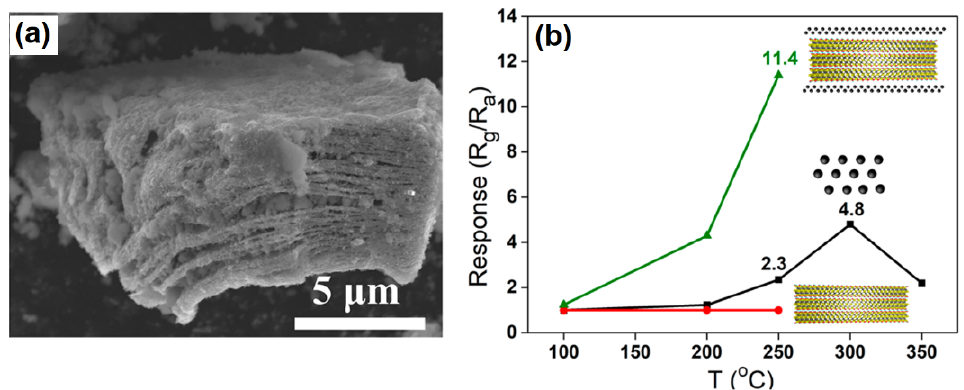
Figure 14. ( a ) TEM image of T 3 C 2 T x /CuO composite. ( b ) Gas sensor response of CuO, T 3 C 2 T x and T 3 C 2 T x /CuO composite to 50 ppm of toluene. Adapted with permission from [48]. Copyright © 2020, American Chemical Society.